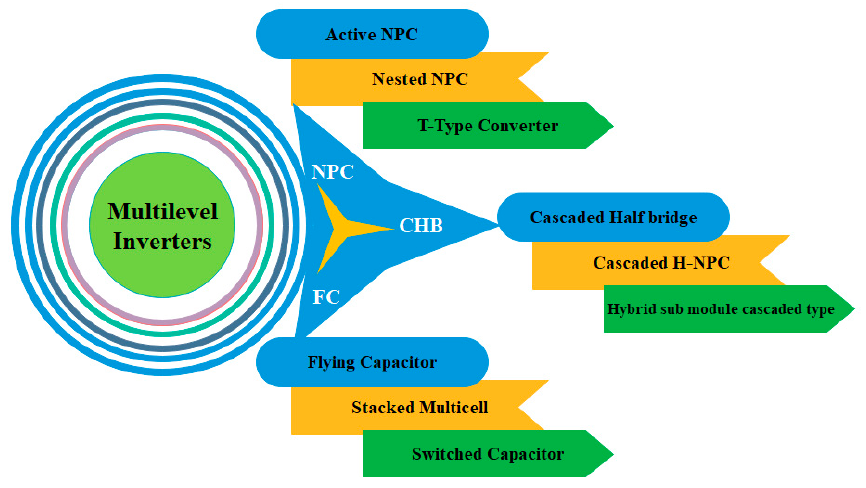
Figure 1. Multilevel inverter classifications.